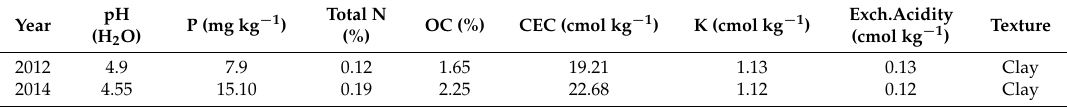
Table 1. Soil physico-chemical properties of the experimental area before soybean